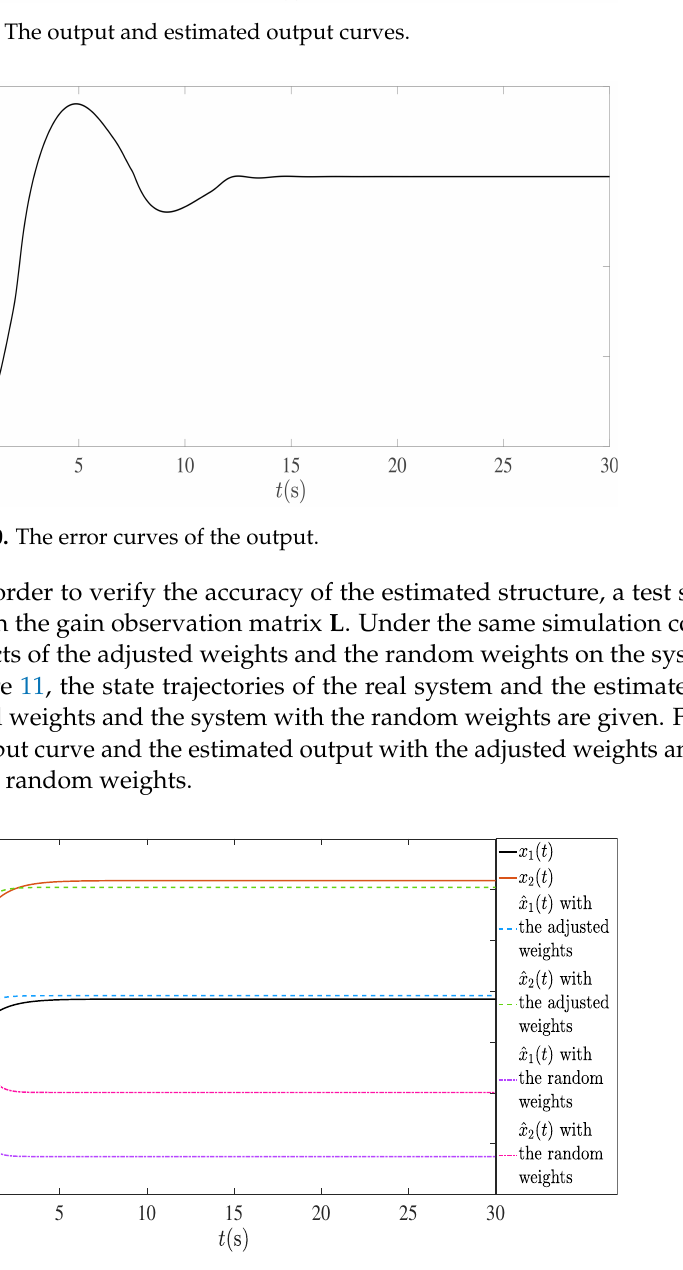
Figure 11. The state and estimated state with the adjusted weights and state with the random weights